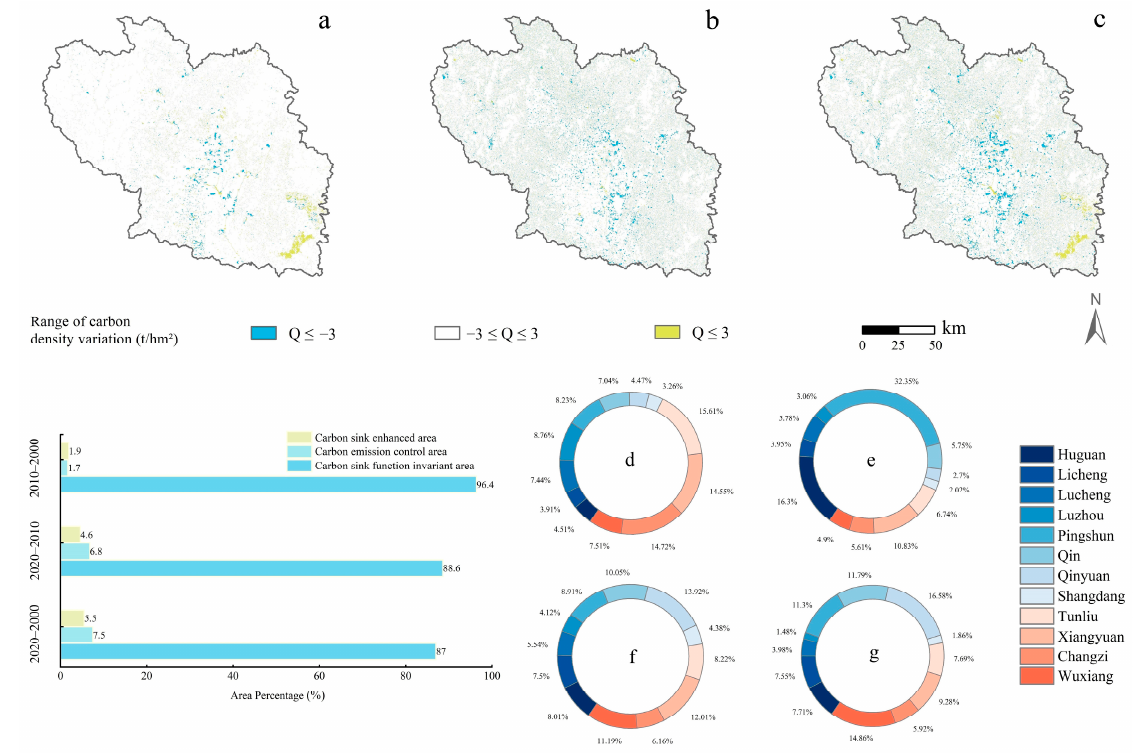
Figure 9. Spatial distribution of carbon density and carbon function areas in Changzi County from 2000 to 2020. ( a – c ) are the carbon sink function zoning maps for 2000–2010, 2010–2020, and 2000–2020, respectively; the bars are the area share of each carbon sink function zone; the rings are the area share of each county’s carbon emission zone and carbon sink function enhancement zone, ( d ) is the carbon emission area in 2000–2010, ( e ) is the carbon sink enhancement area in 2000–2010, ( f ) is the carbon emission area in 2010–2020, and ( g ) is the carbon sink enhancement area in 2010 − 2020.